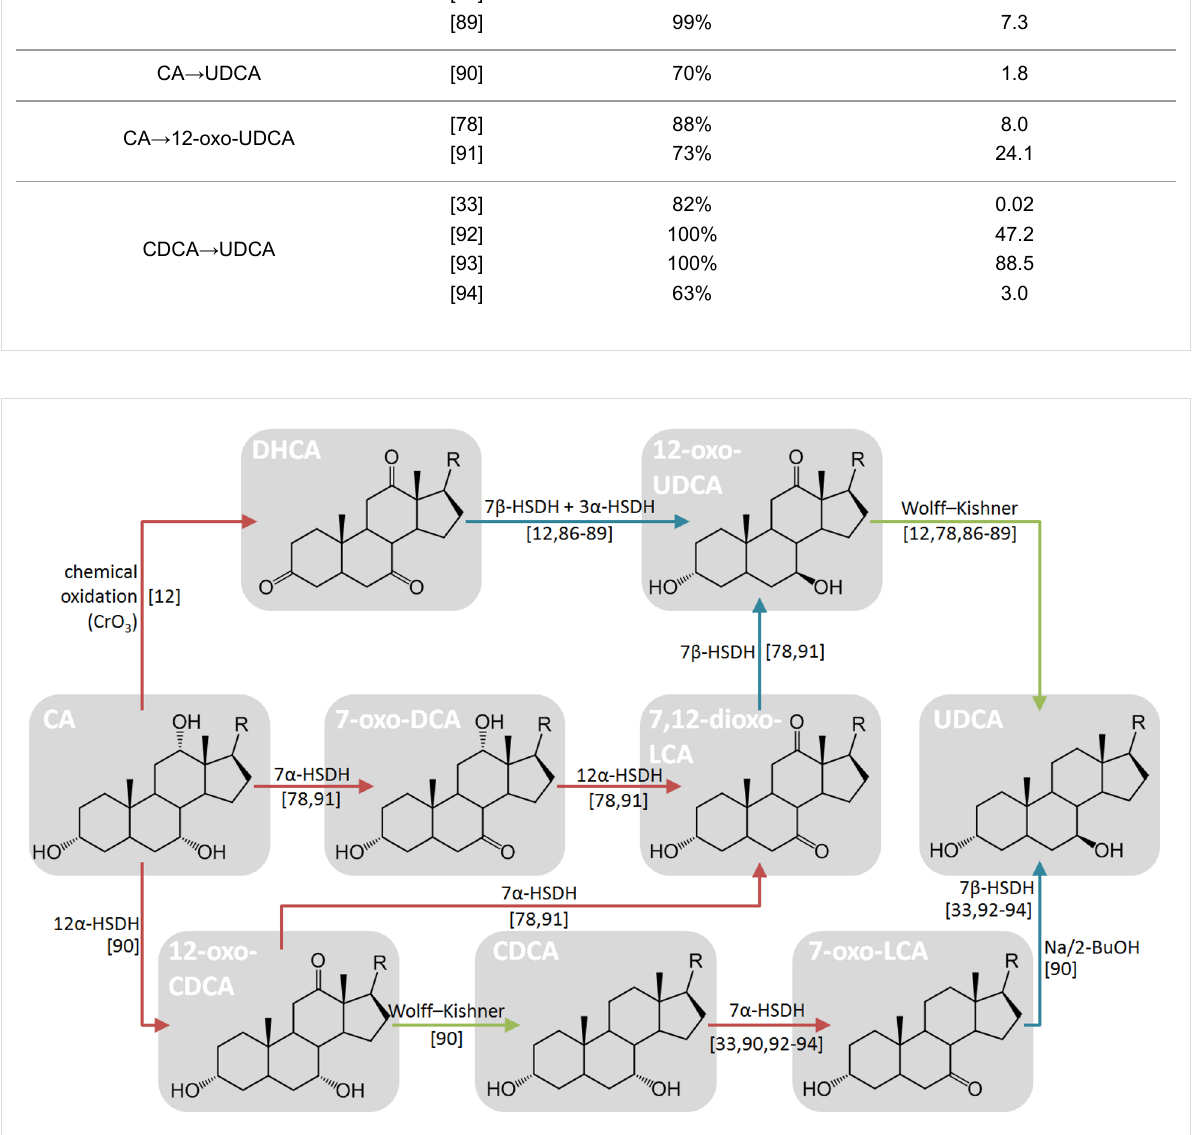
Figure 6: Overview of the chemoenzymatic process for the production of UDCA from CA: The oxidation, reduction and dehydroxylation reactions are highlighted with a red, blue and green arrow, respectively. Names of compounds are indicated in the box. The general stereoinformation of steroid scaffold is shown in Figure 2. R = 4-pentanoic